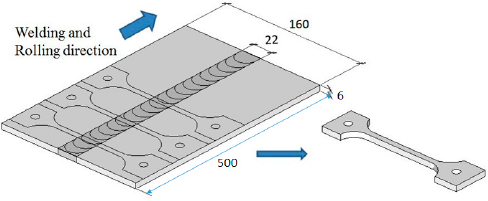
Figure 2. Subtraction of the plate specimen. Figure 3. Subtraction of the small round bar specimen: BM: Base metal, SZ: Stir zone at the center of joint, HAZ: Heat affected zone with the lowest hardness.